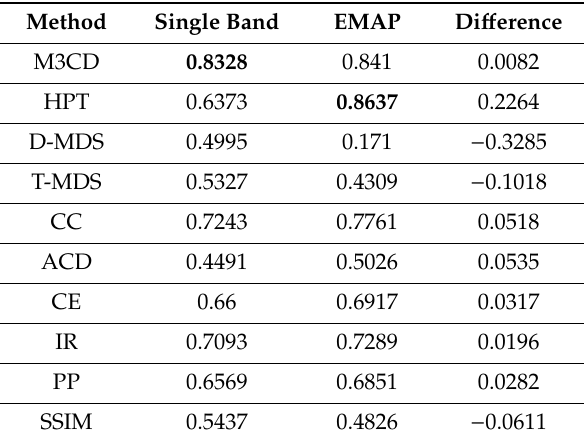
Table 5. AUC values and di ff erences between single band and EMAP cases for dataset-4. Bold numbers indicate the best performing method in each column.